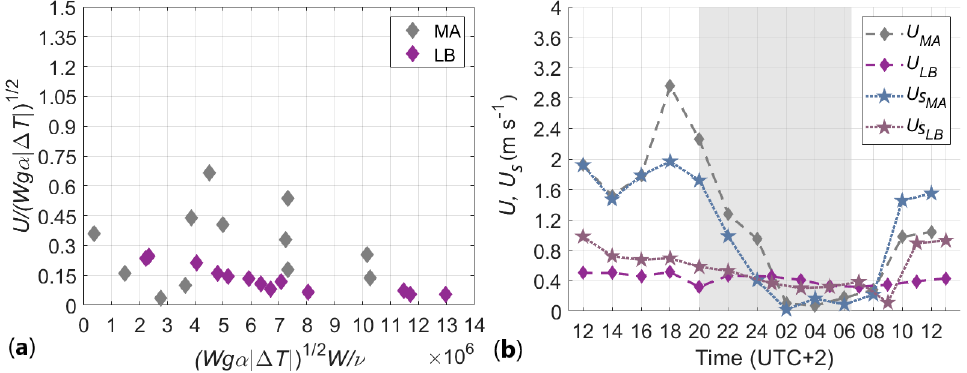
Figure 8. ( a ) Normalized UHI convergence velocity as a function of the Reynolds number. ( b ) Comparison of the total parametrized velocity U s (dashed lines with diamonds) with the measured wind speed U (dotted lines with pentagrams) within the canyons. The shadowed region defines the nocturnal period between sunset (2000 UTC) and sunrise (0630 UTC).